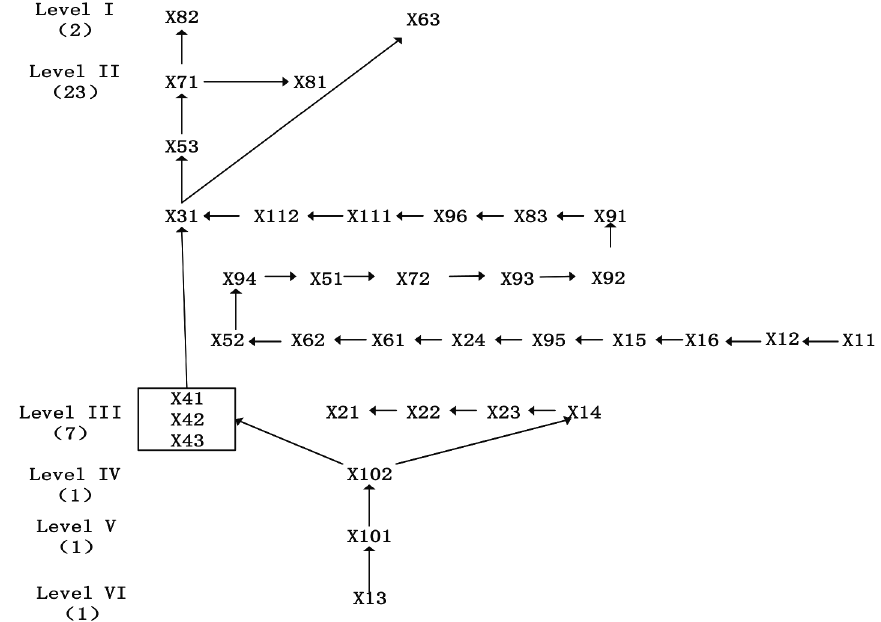
Figure 2. ISM model for risk factors of PPP projects